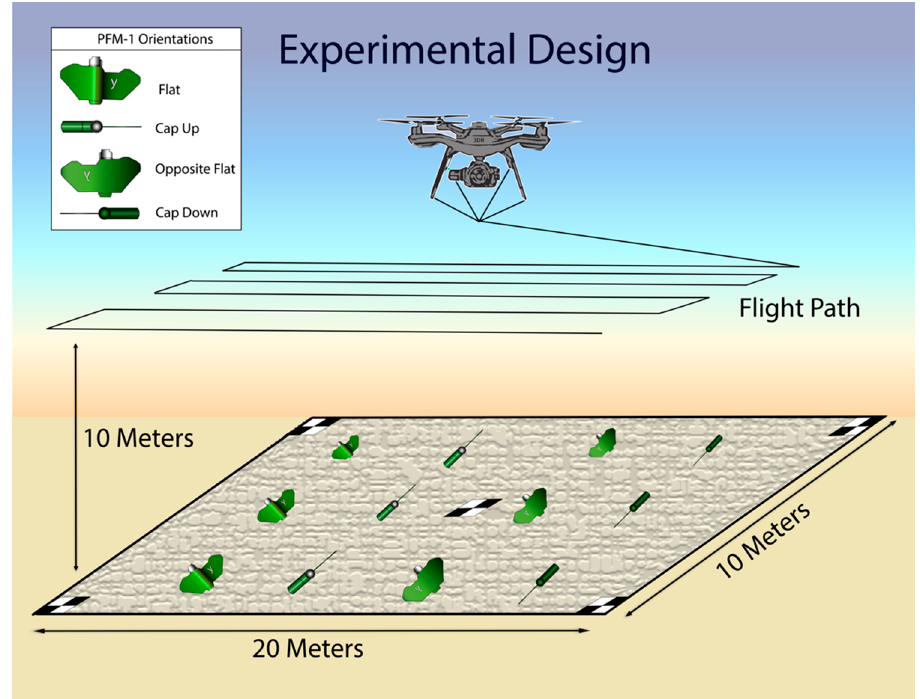
Figure 3. Experimental design and four orientations of PFM-1 landmines.